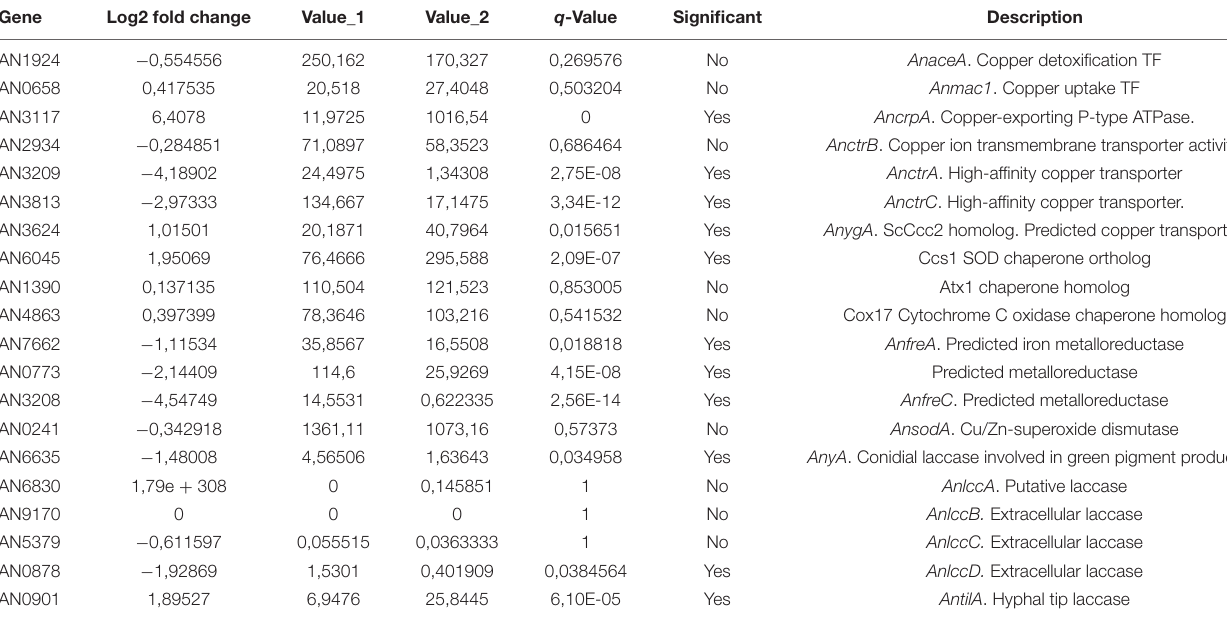
TABLE 1 | RNA-seq data of the copper homeostasis genes and the copper related protein coding genes. Gene Log2 fold change Value_1